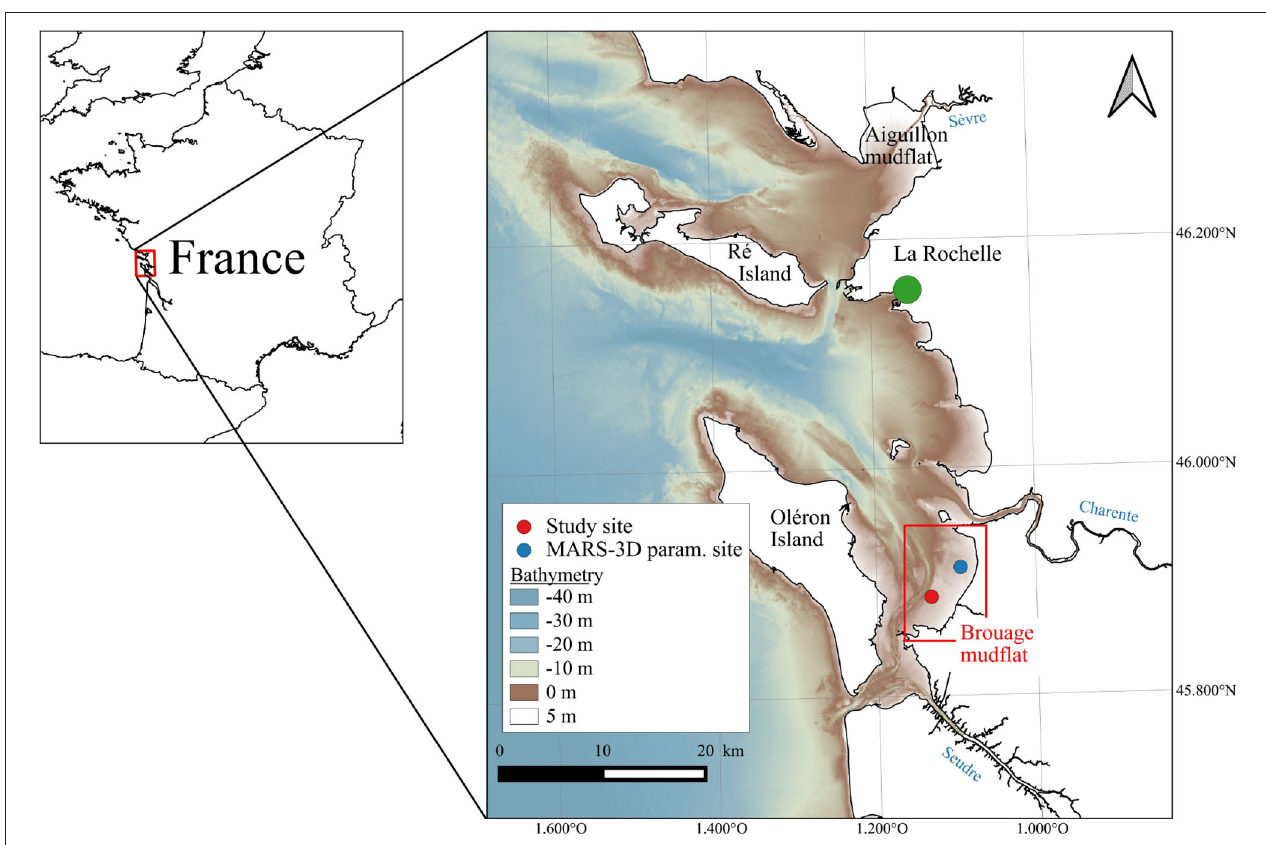
FIGURE 1 | Bathymetry of the model domain covering the Pertuis Charentais Sea (source: